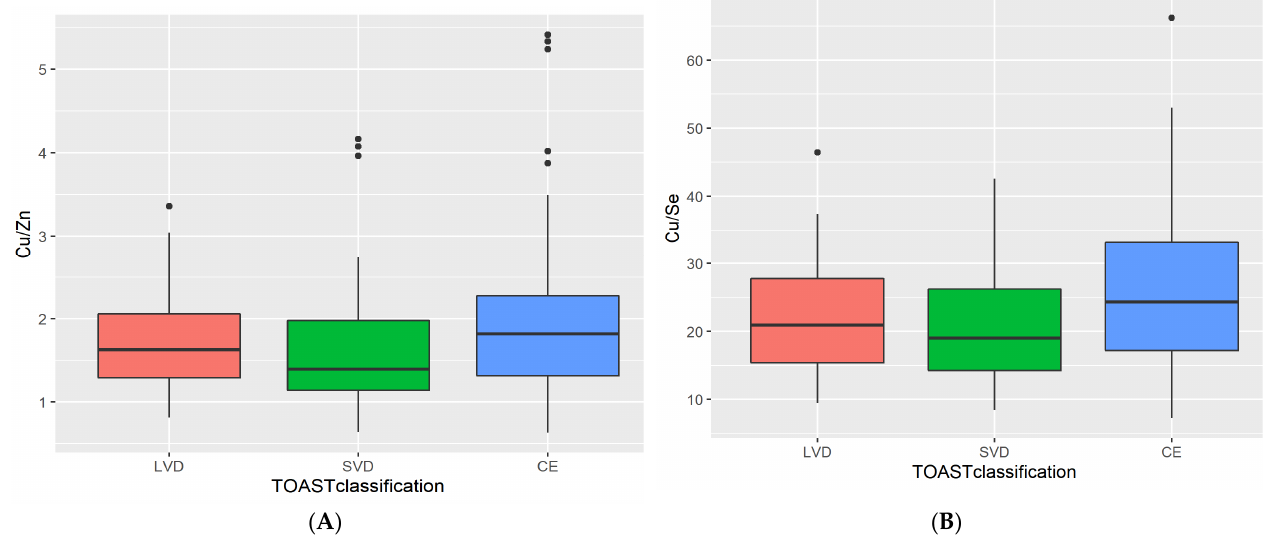
Figure 5. Box plot depicting the results for serum Cu/Zn ( A ) and Cu/Se ( B ) molar ratio levels in patients with acute ischemic stroke in relation to the The TOAST (trial of ORG 10172 in acute stroke treatment) classification. The cardioembolic group showed higher values both in Cu/Zn and Cu/Se molar ratios in patients with AIS. Abbreviations: Cu, Copper. Zn, Zinc. LVD, Large-vessel disease. SVD, Small-vessel disease. CE, Cardioembolic.